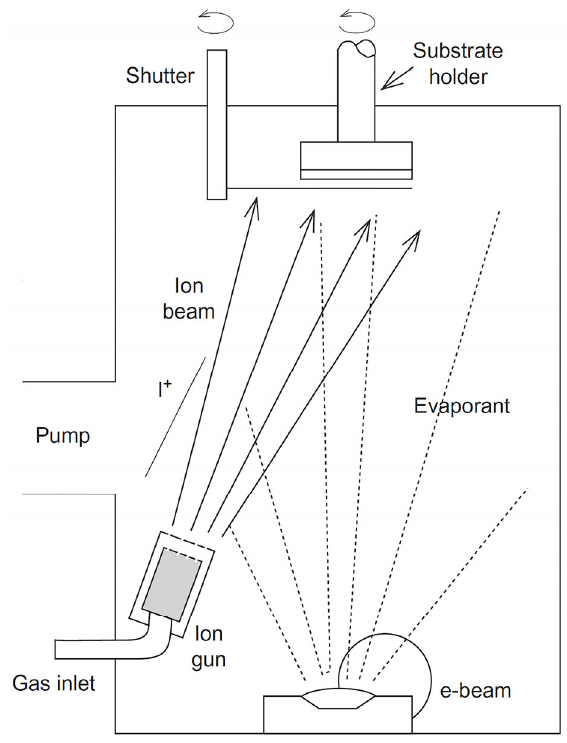
Fig. 3 Vacuum-based ion plating system using an ion gun for bombardment and electron-beam evaporation source. Reproduced with permission from Ref. [42], © Elsevier,